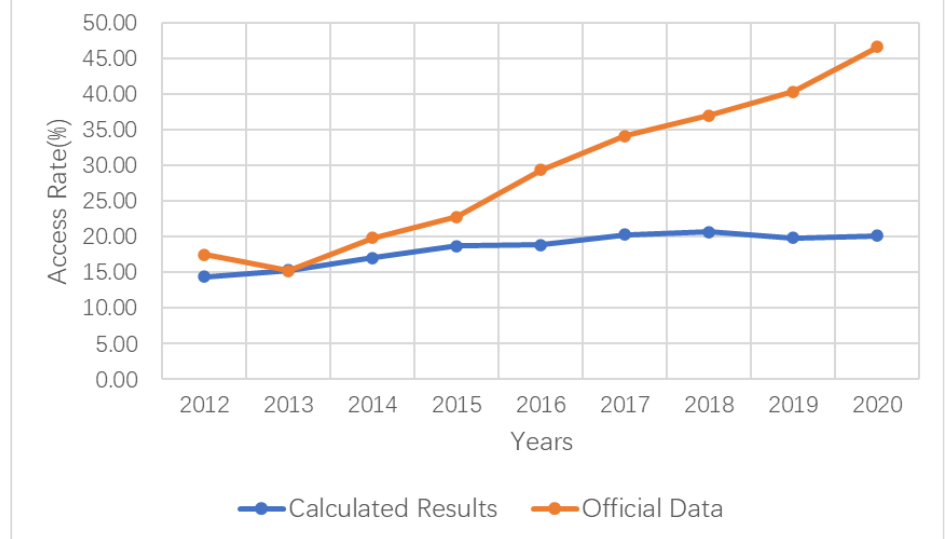
Figure 19. Comparison between the calculated national grid access rates and the official electricity access rates data of Rwanda provided by the World Bank from 2012 to 2020.